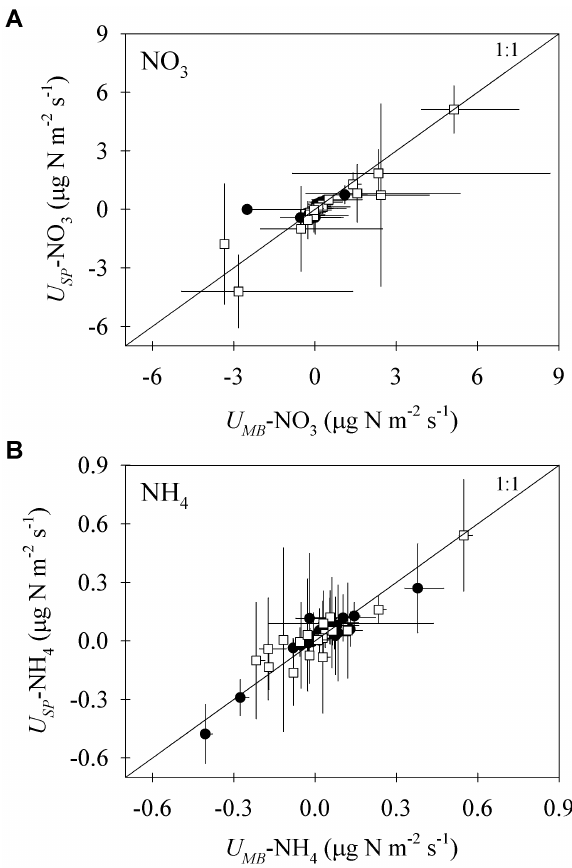
Fig. 1. Relationship between the net uptake rates estimated with the mass balance approach ( U MB ) and the spiralling approach ( U SP ) for (A) NO 3 and (B) NH 4 . White squares and black circles cor- respond to values from Fuirosos ( n = 20) and Santa Fe ( n = 25) streams, respectively. Error bars are the confidence intervals esti- mated with the two approaches (see text for details). The 1:1 line is shown in each case.